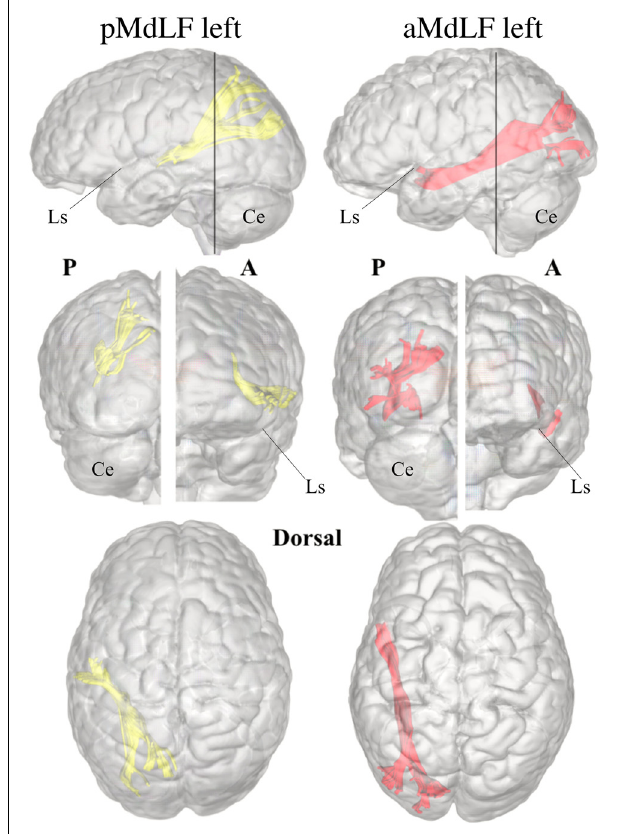
FIGURE 8 | Three-dimensional reconstruction within a “glass-brain” of origin, course, and terminations of the two MdLF segments, displayed separately. The pMdLF (yellow) and aMdLF (red) are displayed on the left side on sagittal projection (first row) , on coronal projection (from both posterior and anterior view, second row ), and axial dorsal view (third row) . See the text for further details. A, anterior view; P, posterior view; Ls, lateral sulcus; Ce,